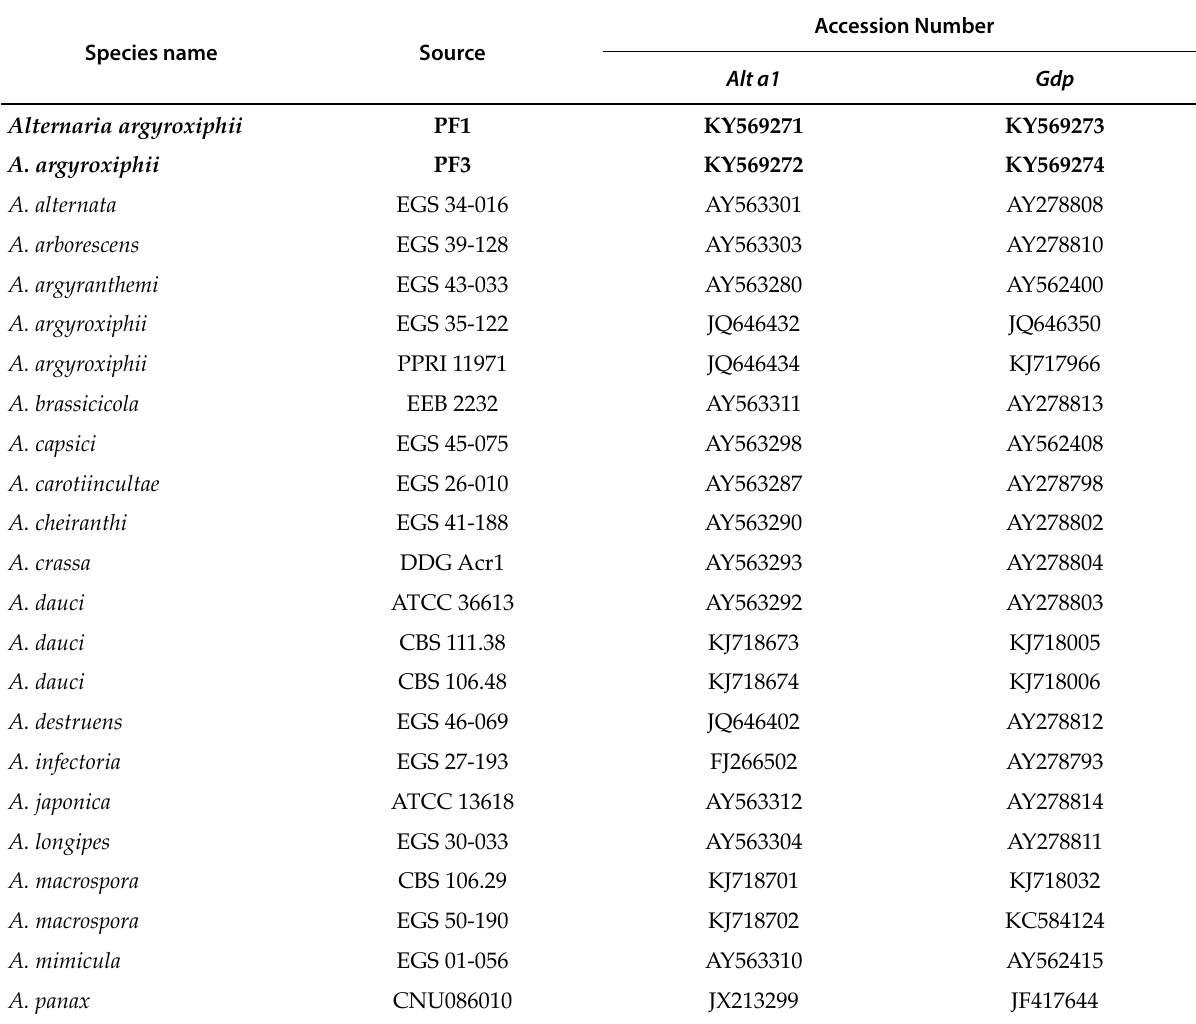
Table 1. Detailed information on the isolates used in this study, their sources and GenBank accession numbers for se - quences used in phylogenetic